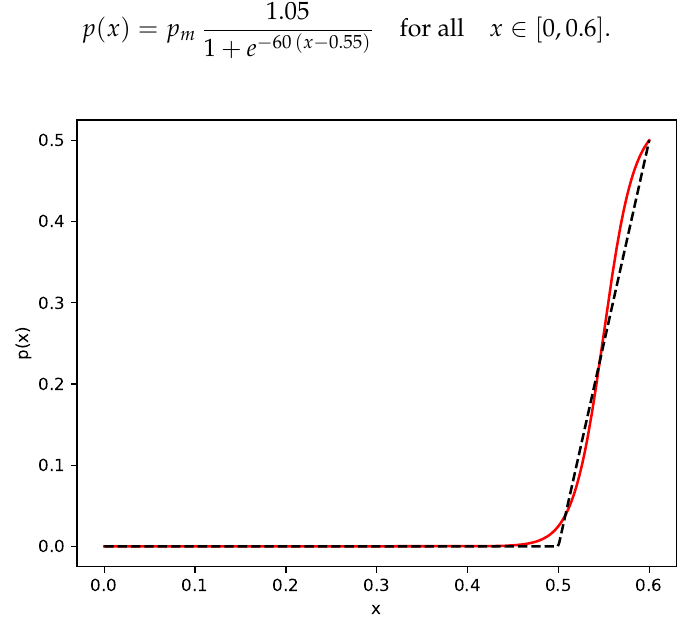
Figure 2. Graph of p defined as a sigmoid (red) and the piecewise form (dashed black), for p m =